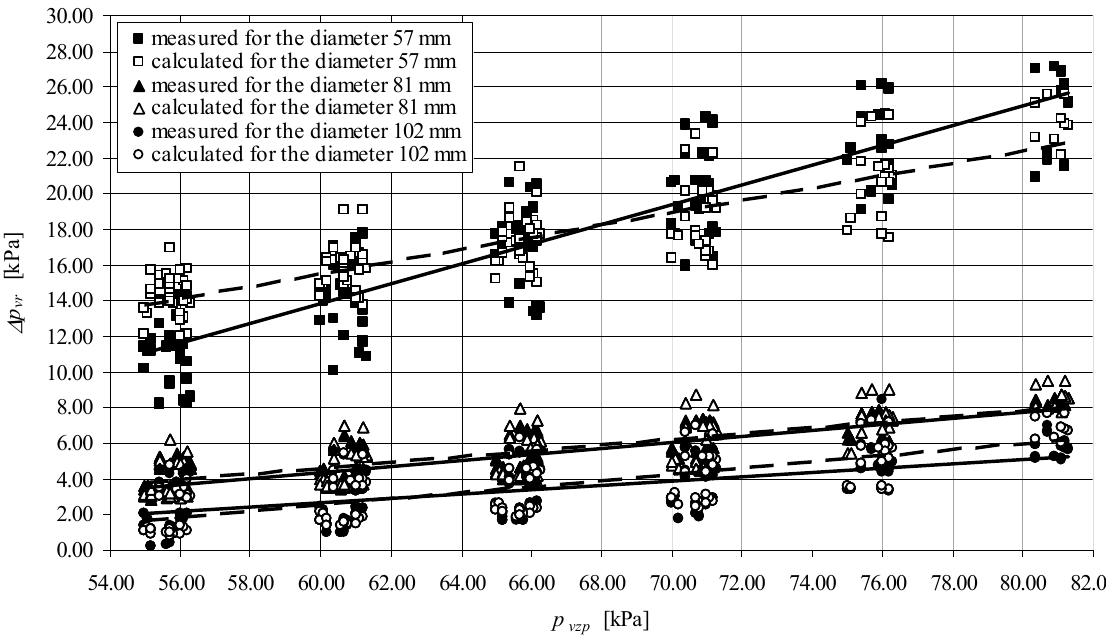
Figure 7. Functional dependence between the negative pressure difference ( Δ p vr ) and the vacuum container pressure ( p vzp ) for the data calculated from the empirical formula and for the measured